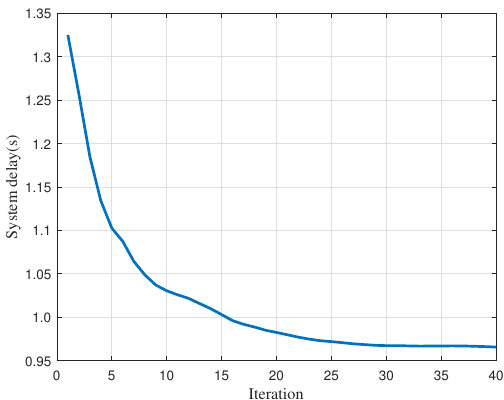
Figure 9. Convergence of proposed